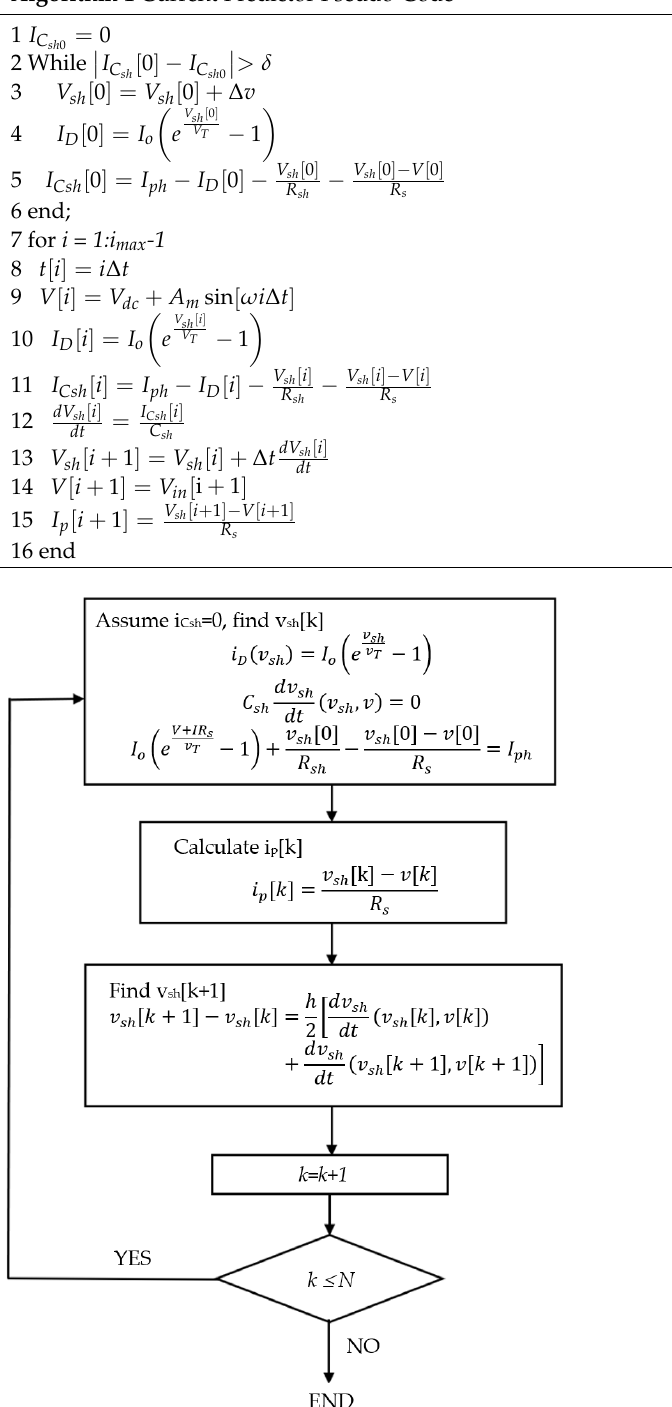
Figure 2. Current Predictor Flow Chart.